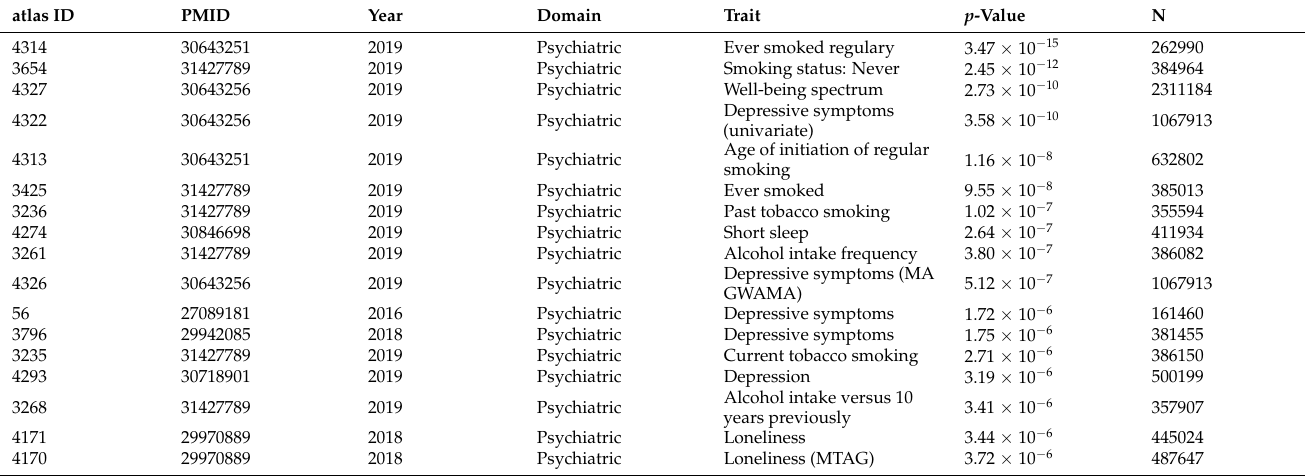
Figure 7. QTLs linked with murine phenotypes gain precision with the use of relevant PheWAS hits in a GWAS atlas. An example for this is for vertical activity (Chr 3 51.723-56.473 Mb) includes a number of genes with relevant psychiatric, neurological and cognitive PheWAS hits. Maml3 is associated with alcohol dependence and depression.